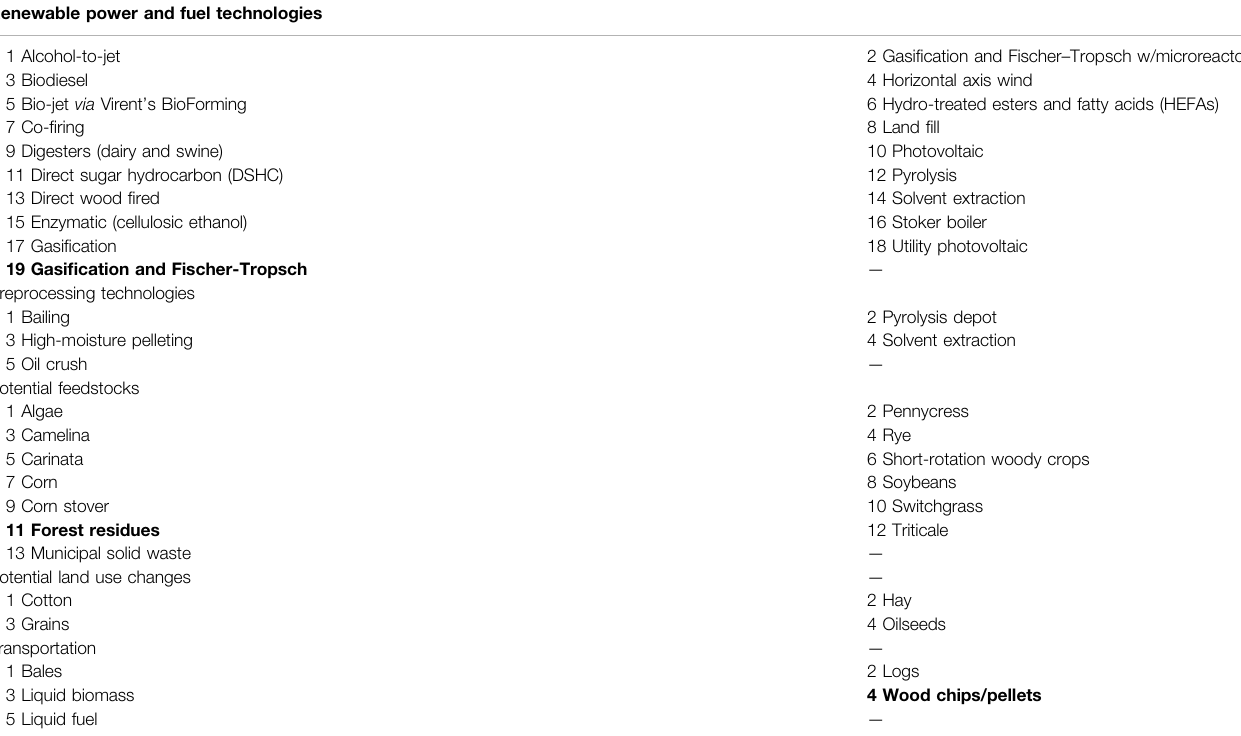
TABLE 1 | Conversion and renewable energy technologies, feedstocks, and land-use changes incorporated into the renewable energy economic analysis layers modeling